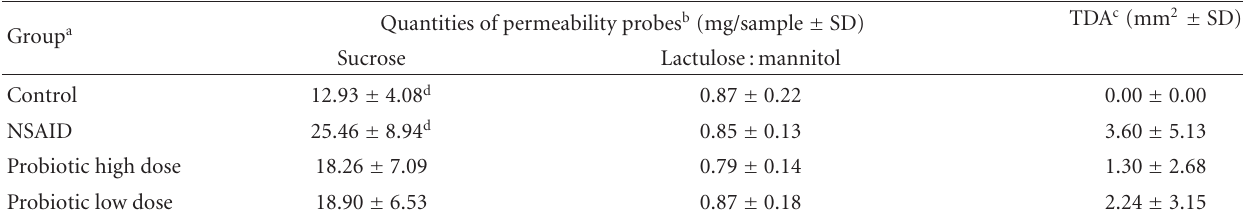
Table 4: Dose-responsiveness of Bifidobacterium lactis 420 against indomethacin-induced side e ff ects. Group